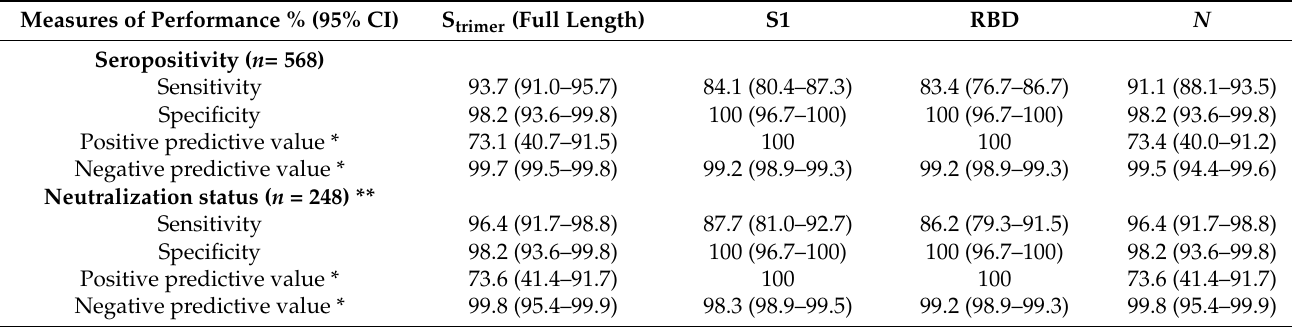
Table 1. Performance of the 11-plex multiplexed bead-based immunoassays (MBIA) panel in detecting anti-SARS-CoV-2 antibodies using SARS-CoV-2 seropositive samples and samples originating from the pre-SARS-CoV-2